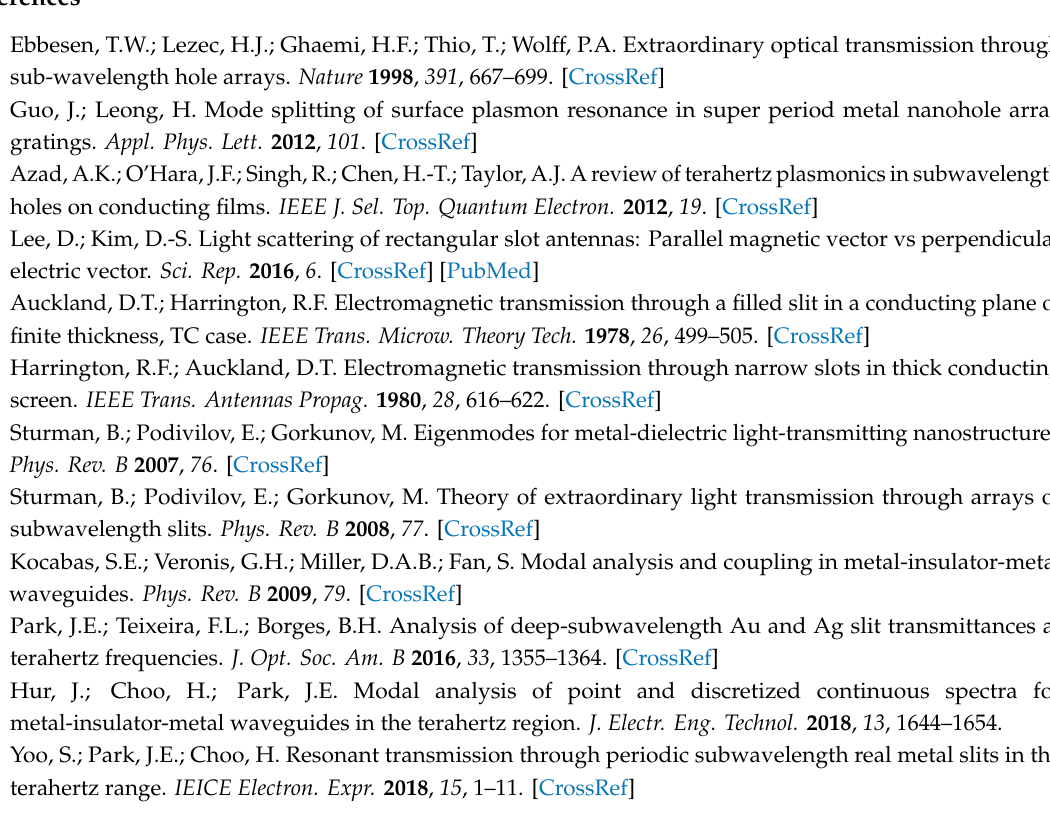
Figure S1: Physical meaning of resonant transmission when 2 g = 4 nm, Figure S2: Physical meaning of resonant transmission when 2 g = 8